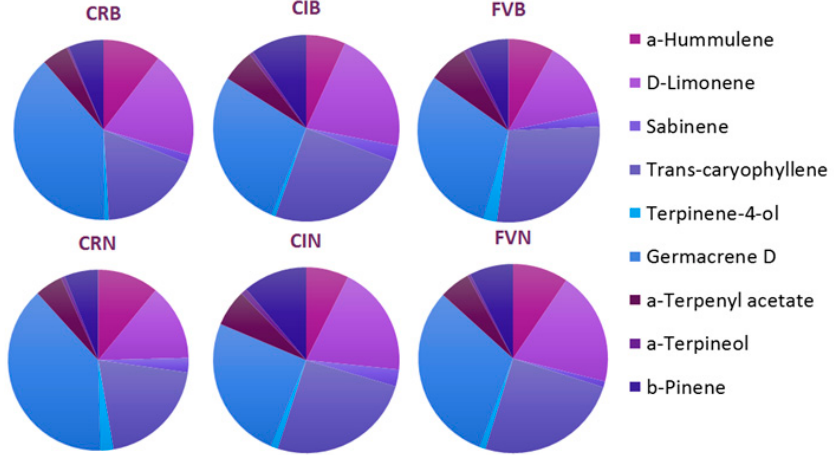
Figure 2. Mean amounts of the nine most frequent VOCs for classifying Pinus mugo buds and nee- dles harvested from the mountainous areas Cindrel-Iujbea, F ă g ă ra ș -Vi ş tea, Cozia-Rotunda in Ro- mania, by using KMO.